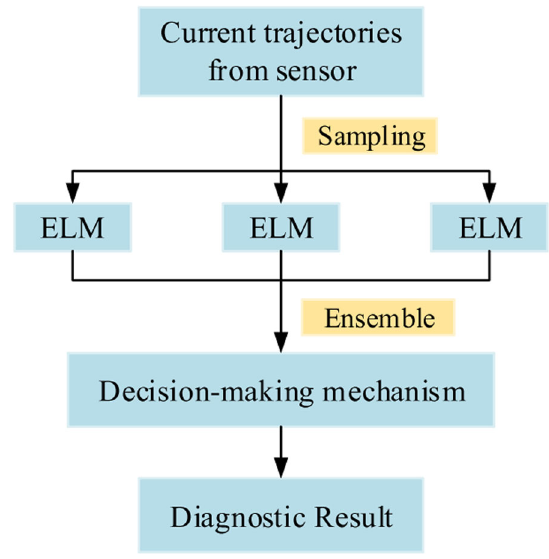
Fig. 6 Structure of Ensemble ELM